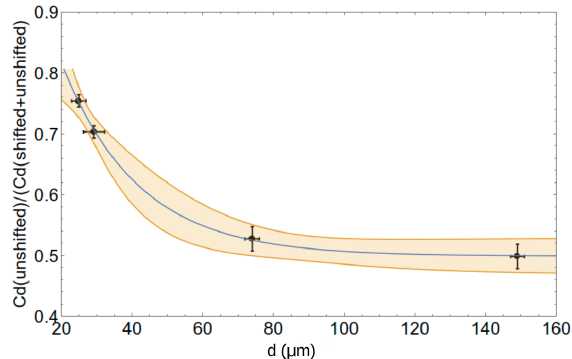
state of 1 Figure 4. Top panel: Evolution of the B ( E 2) values from the first 2 + state over the Zr isotopic chain over mass number A . Bottom panel: Energy di ff erences between the 0 + 2 + states in the Zr 1 , 2